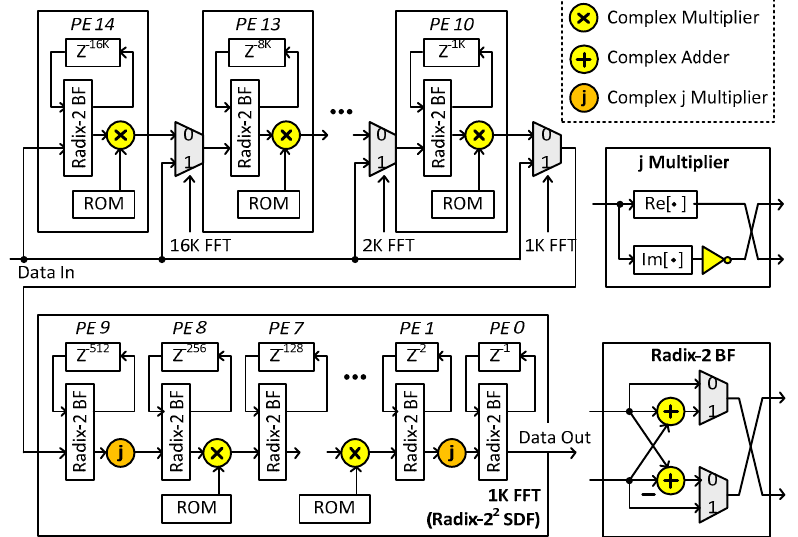
Figure 11. Block diagram of variable FFT.